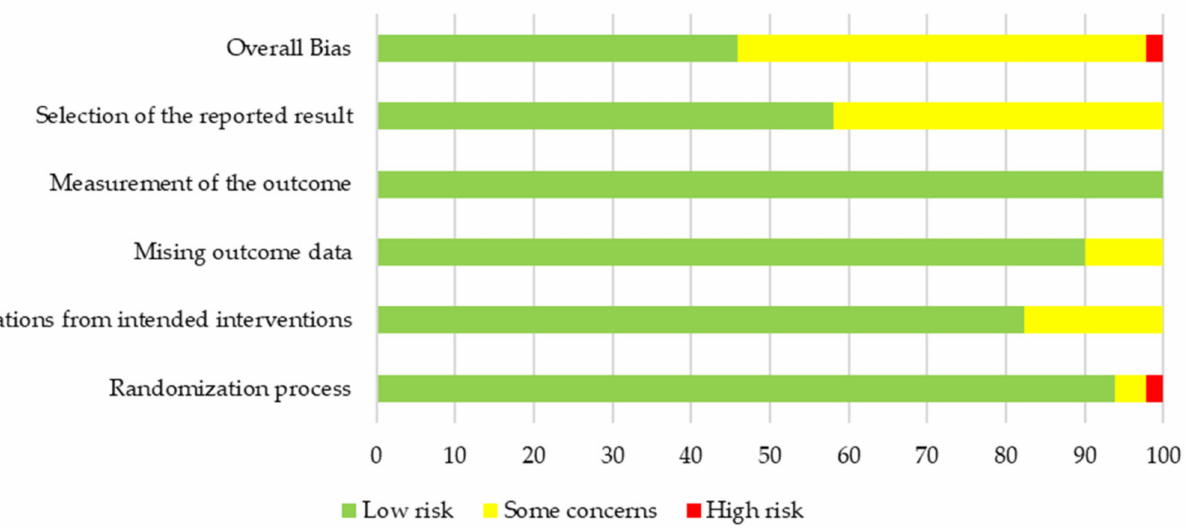
Figure 2. Overall risk of bias results for the primary outcome of body